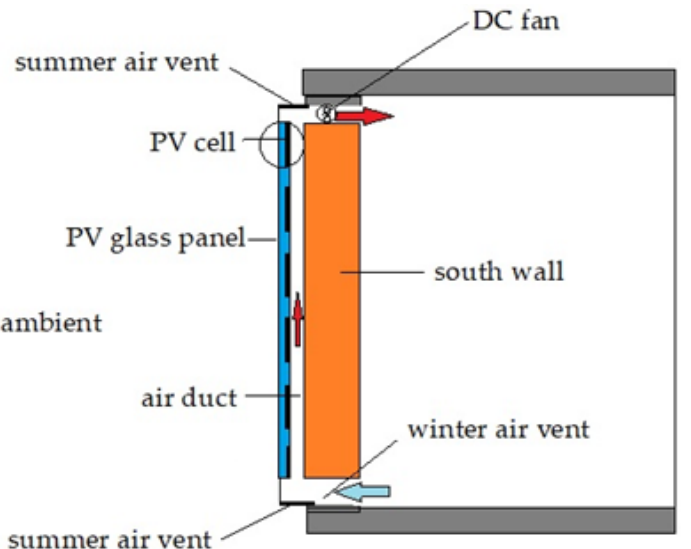
Figure 9. BIPV facade provided with vents and DC fan [52].